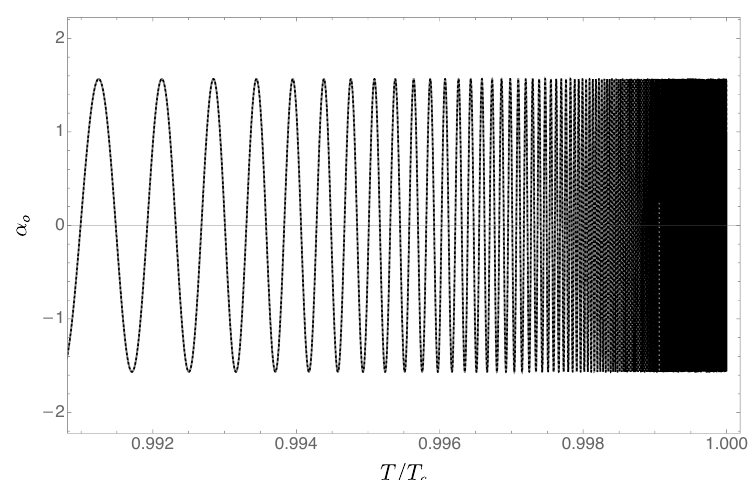
−(cid:112) = /π (which will determine the subsequent Kasner Figure 5: Oscillations in α 8 c o 5 exponent) as T → T . The solid gray line is numerical data and the black dotted curve c is a fit to the expression (25). The numerics has m 2 = − 2 and q = 1. q = 1 we find B ≈ 0.491 ( 8 ) and C ≈ 1.945 ( 6 ) . The amplitude depends only on the